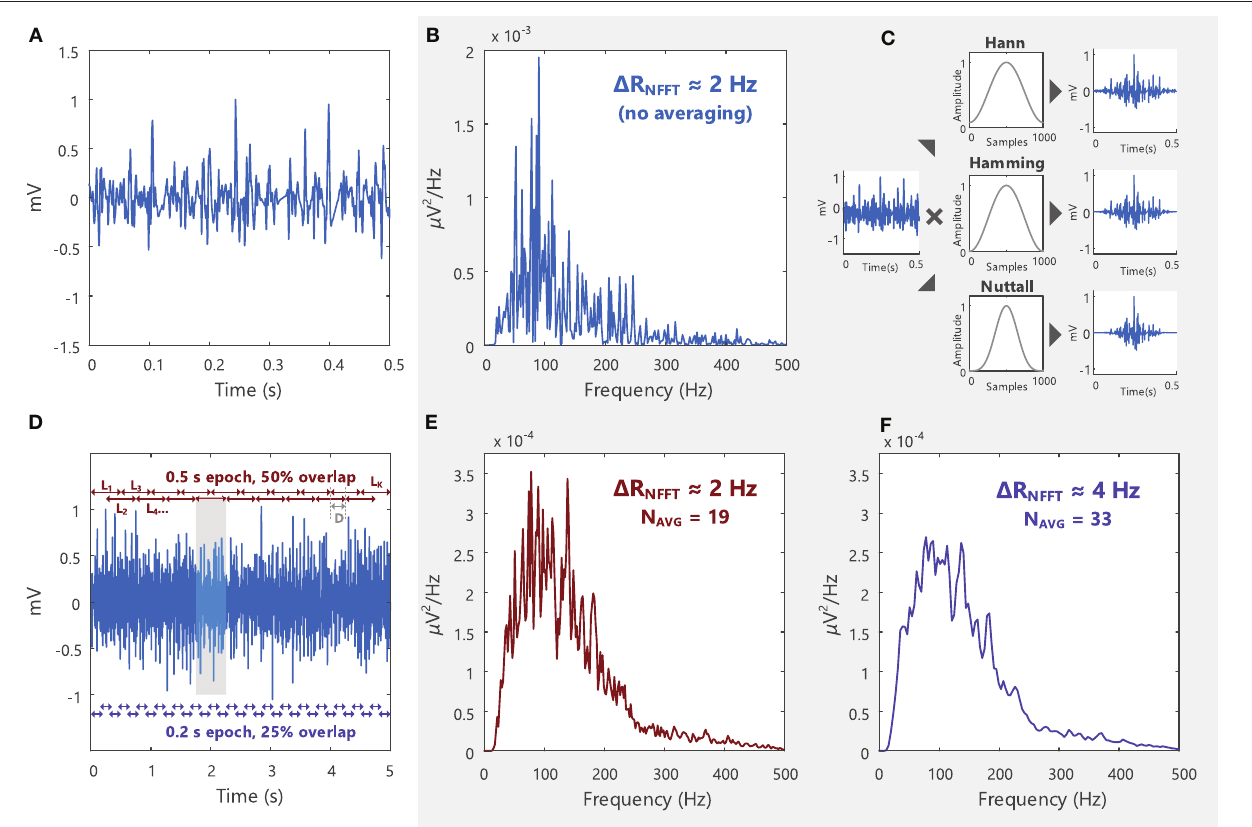
FIGURE 9 | (A) An EMG signal sampled at 2,000 samples/s in the time domain and (B) the power spectrum of the signal in the frequency domain. The signal spectrum contains several spurious peaks. (C) Welch’s method breaks the total signal (5s long, shown in D ) into shorter segments (0.5s) and multiplies (convolves) each segment by a window function (some examples are the Hann, Hamming, and Nuttall windows) before averaging all the modified segments. See Example (viii) in Tutorial Code. (D) In Welch’s averaging method, the EMG signal is divided into a number of segments (K). K depends on the length of the segment (L) and the degree of overlap between successive segments, Equation 3 in Supplementary Material . Each successive segment starts D samples after the previous segments. (E) By obtaining an average power spectral density across K segments, the spurious peaks in (B) are reduced. (F) The smoothness of the power spectral density